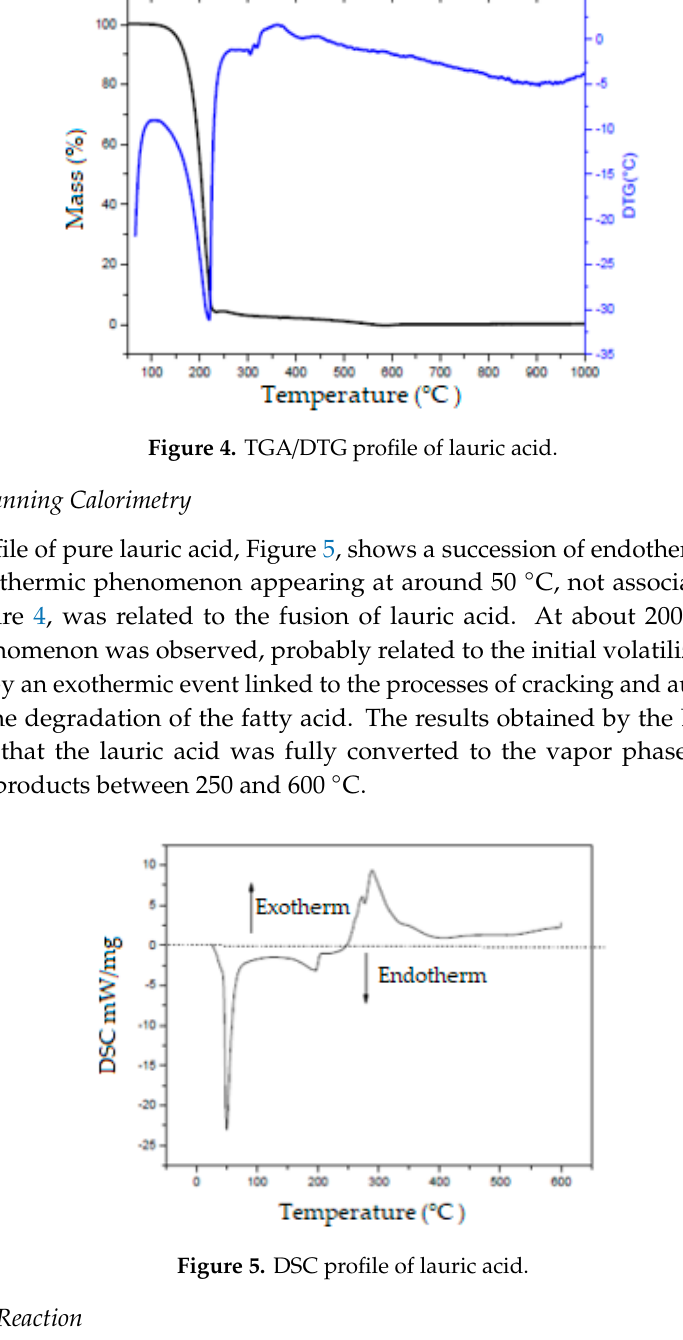
( b ) Figure 3. TGA profile of SAPO-5 catalyst ( a ); TGA profile of Al-MCM-41 catalyst ( b ). In Figure 3a, the thermogravimetric analysis of the SAPO-5 catalyst is presented, in which three regions of mass loss can be observed. The first 8% mass loss event, from room temperature up to 200 °C, was associated with the desorption of adsorbed water on the outer surface and occluded in the pores. The second step had a loss of 10% in the range of 200 °C–470 °C, with a maximum rate from 440 °C–470 °C, which was ascribed to the desorption of triethylamine (template) occluded in the channels. Finally, the third region, between 470 and 750 °C, with a loss of 2%, was related to the desorption of the occluded channel surfactant and to the decomposition of the protonated amine (TEA + ) [23]. In Figure 3b, the first mass loss event (2%) was related to the loss of water physically adsorbed in the pores